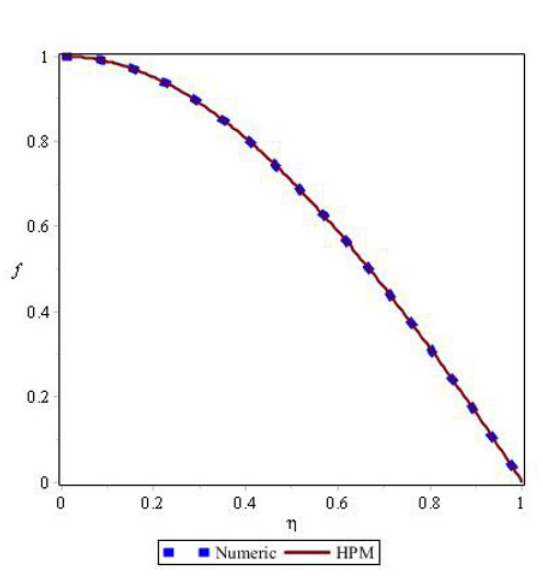
Figure 16. Comparison between the obtained solutions for f HPM and Numerical Method ( A ∗ = 1 , Ha = 0 , Re = 50 , ( η ) by α = 3 ◦ , φ = 0 ).